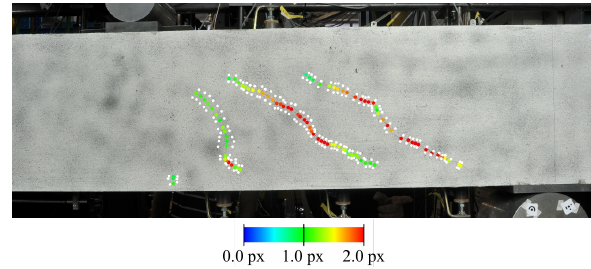
Figure 17. Histograms of the residuals to the manual crack